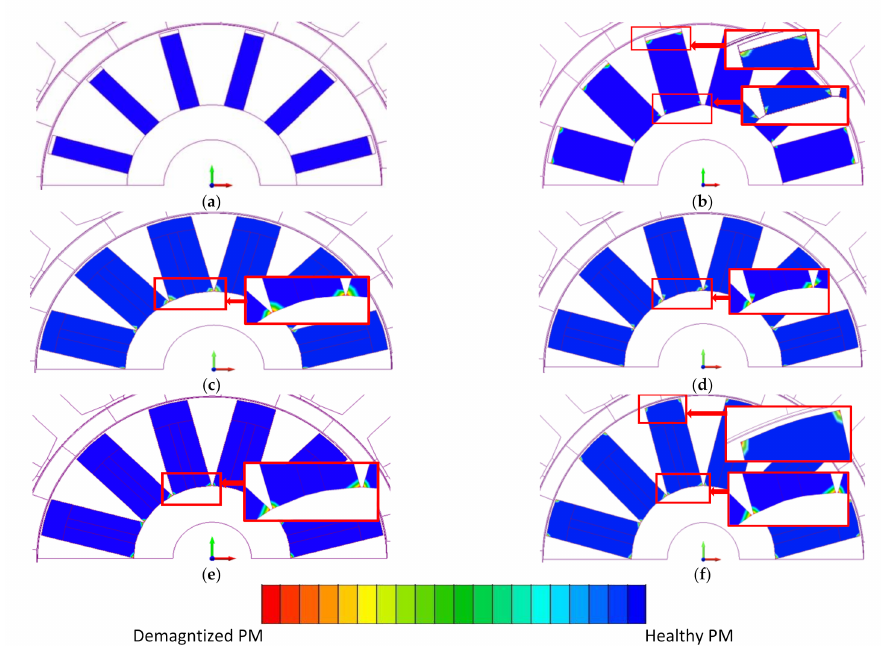
Figure 15. Risk of demagnetization for various designs: ( a ) Dy-NdFeB Design at (140 ◦ C) ( b ) Dy-free NdFeB Design at (140 ◦ C) ( c ) Dy-NdFeB with Ferrite Design at ( − 40 ◦ C) ( d ) Dy-NdFeB with Ferrite Design at (140 ◦ C) ( e ) Dy-free NdFeB with Ferrite Design at ( − 40 ◦ C) ( f ) Dy-free NdFeB with Ferrite Design at (140 ◦